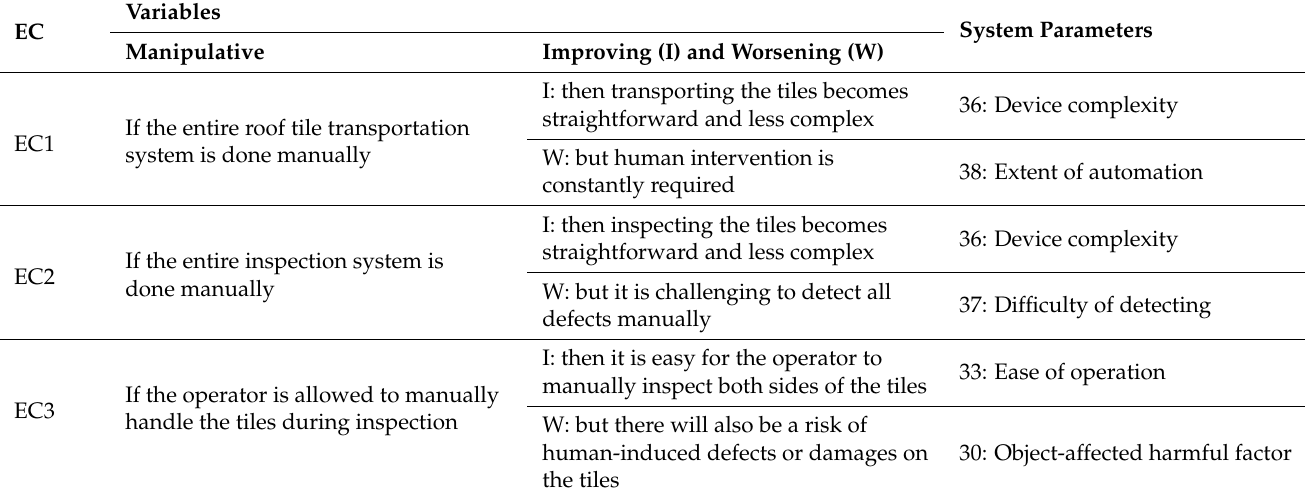
Table 2. Linkages between engineering contradictions and the system